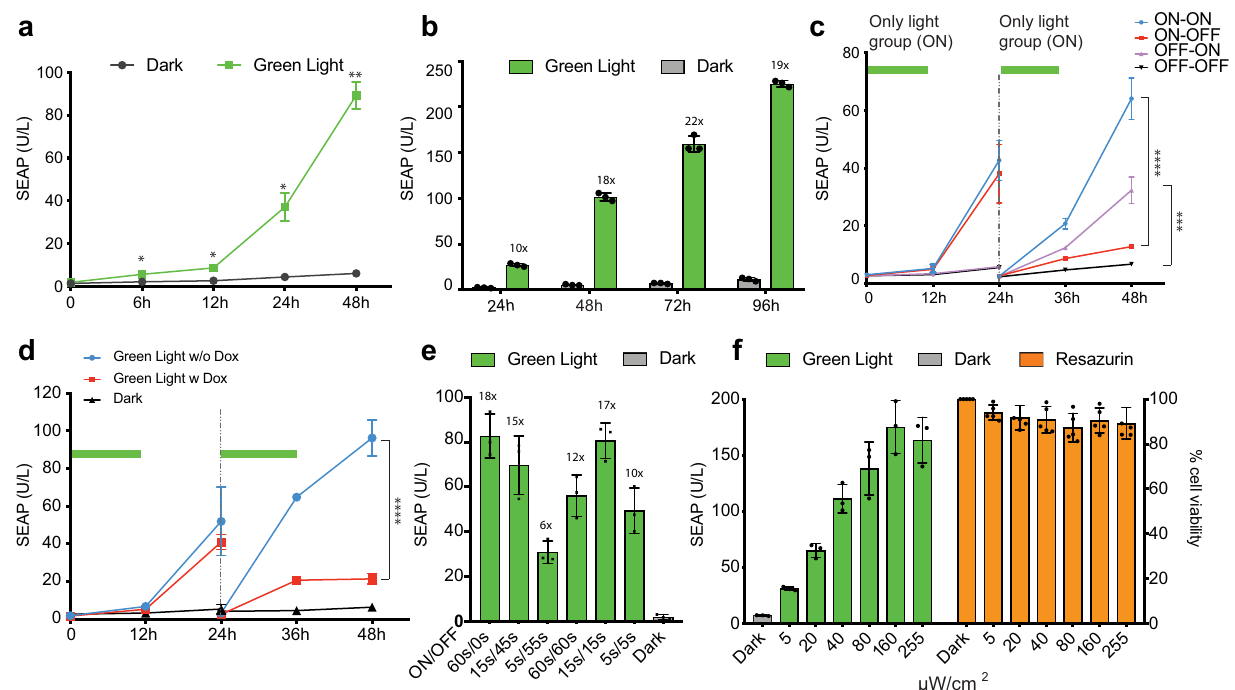
Fig. 3 Characterization of Glow Control-transfected cells. HEK293T cells were transiently co-transfected with pMMZ284 (P SV40 -Myr-TtCBD-nGFP-pA), pMMZ272 (P SV40 -TtCBD-TetR-VP16-pA), and pTS1017 (P TetO7-CMVmin -SEAP-pA). Cells were illuminated with pulsed green light (545 nm; 15 s ON/45 s OFF, and 88 μ W/cm 2 ) for 12 h/day and SEAP levels were assessed in the supernatant of cultured cells at 48 h after the start of illumination, unless indicated otherwise. a In vitro kinetics of Glow Control system in response to green light. Cells were either exposed to pulsed green light or not illuminated. Values are mean ± SD ( n = 3) and statistical signi fi cance between illuminated and un-illuminated groups were calculated using a two-tailed, paired Student ’ s t -test. b SEAP levels in culture supernatant of HEK293T cells were pro fi led at the indicated time points after 12 h/day illumination with pulsed green light. Control cells were not illuminated. c Reversibility of the Glow Control system. HEK293T cells were illuminated with pulsed green light (ON) or were kept in dark (OFF) and SEAP levels were pro fi led every 12 h for 48 h. After 24 h, the culture medium was changed and the cell density was adjusted to 5 × 10 4 cells/well of a 96-well plate. Cells were again illuminated with (ON) or without (OFF) additional 12 h pulsed green light. The values are mean ± SD ( n = 3). Statistical signi fi cance between indicated groups were calculated using a one-way ANOVA. d Doxycycline-controlled transcriptional inactivation of the Glow Control system. HEK 293T cells were illuminated for 12 h with pulsed green light. After 24 h, the medium was changed to medium with or without 1 µ g/ml doxycycline and illuminated for another 12 h. The values are mean ± SD ( n = 3). Statistical signi fi cance between indicated groups were calculated using a one-way ANOVA. e SEAP expression levels in HEK293T cells treated with green light pulses for various periods as indicated. f Light-intensity- dependent Glow Control activity and viability. HEK293T cells were illuminated with green light at different intensities (0 – 300 μ W/cm 2 , left). Viability of green-light-treated cells exposed to different light intensities (left) was assessed by MTT assay (right). Plots show the mean ± SD of n = 3 biologically independent samples. Numbers above the bars indicate fold changes of reporter (SEAP) expression vs. the corresponding Dark group. * p < 0.05; ** p < 0.01; *** p < 0.001; **** p < 0.0001. Source data are provided as a Source Data fi